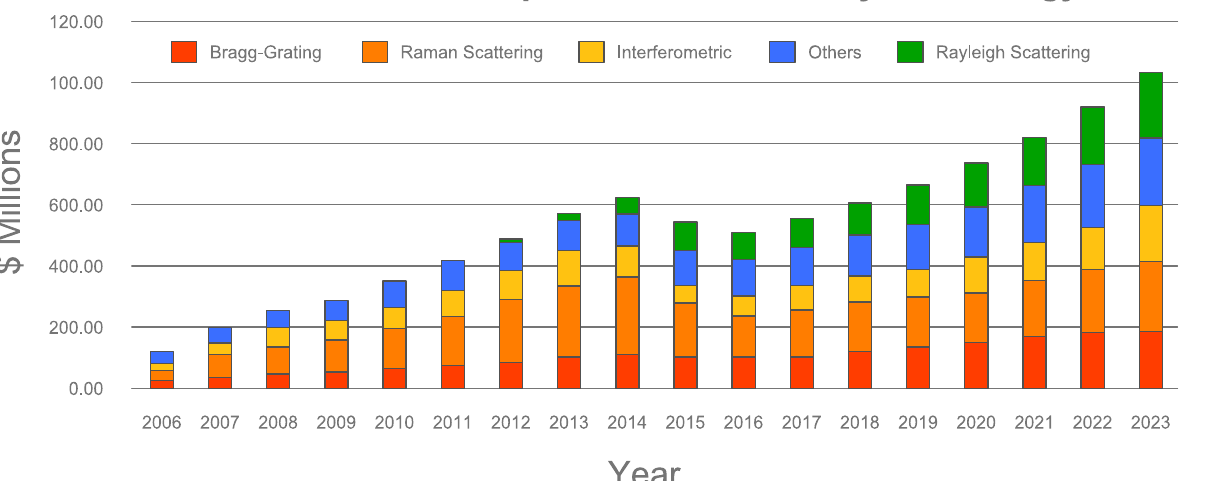
Figure 2. Growth of Optical Fiber Sensors (OFS) technological market